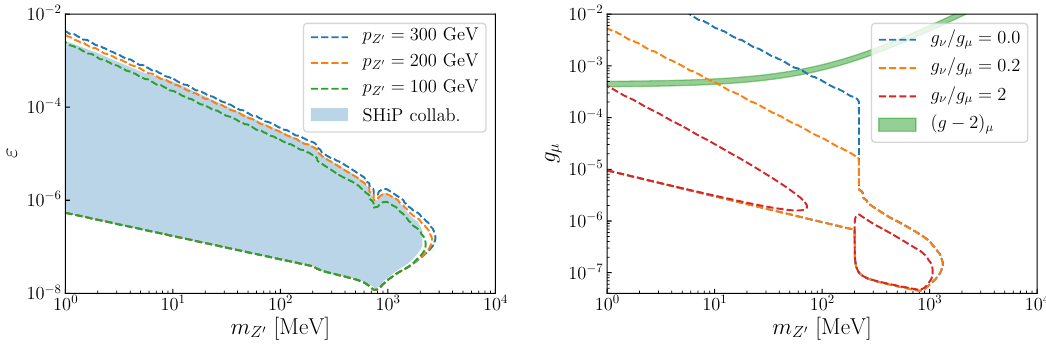
Figure 4 . Left: reproduced bounds (dashed) on ε compared to the bound published by the SHiP collaboration [60] (blue shaded). Right: bounds on the muonic coupling, g decay of Z 0 . The green band in the right panel is the same as in figure 2, and couplings of Z 0 to the electron and quarks are assumed at the loop-induced level given by eq.